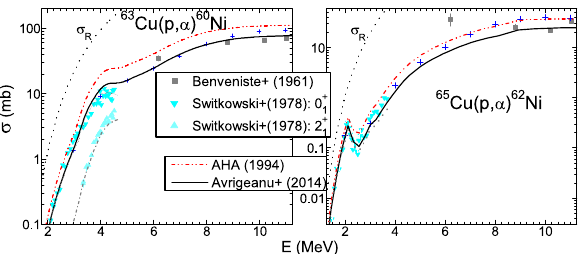
Figure 4. As Fig. 1 but for 63 , 65 Cu( p ,α ) 60 , 62 Ni